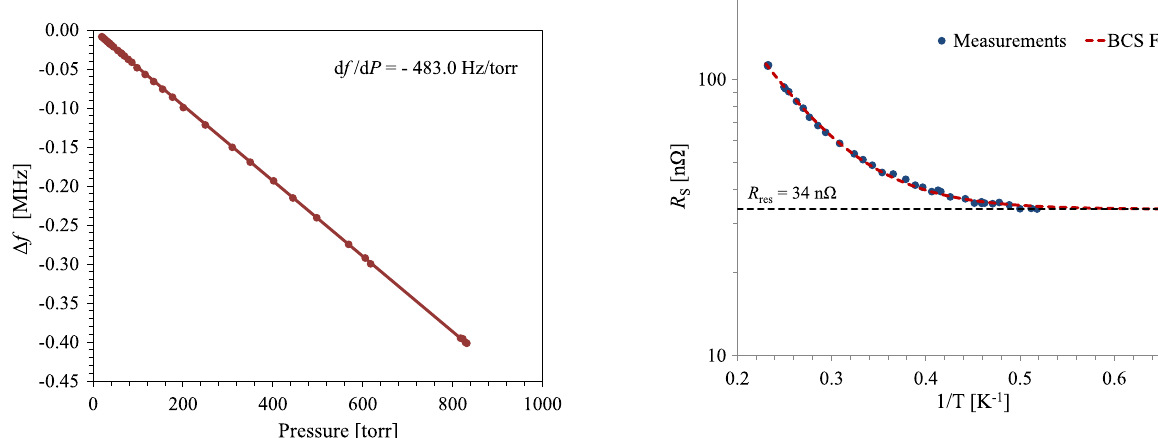
FIG. 15. Pressure sensitivity of the rf-dipole